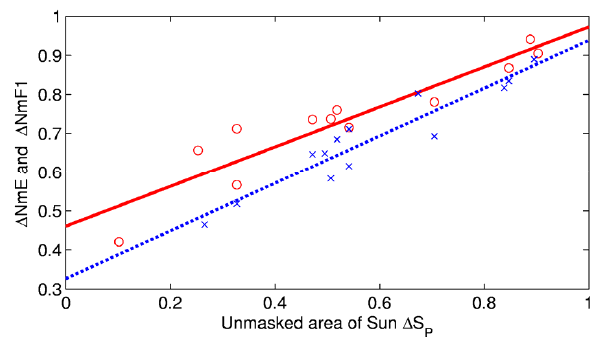
Figure 2. Scatterplots of Δ NmE (circles) and Δ NmF1 (crosses) versus Δ S p and a linear fit for 568 Fig. 2. Scatterplots of 1 NmE (circles) and 1 NmF1 (crosses) versus these observations (solid line for Δ NmE; dashed line for Δ NmF1). 569 1 S p and a linear fit for these observations (solid line for 1 NmE; 570 dashed line for 1 NmF1).